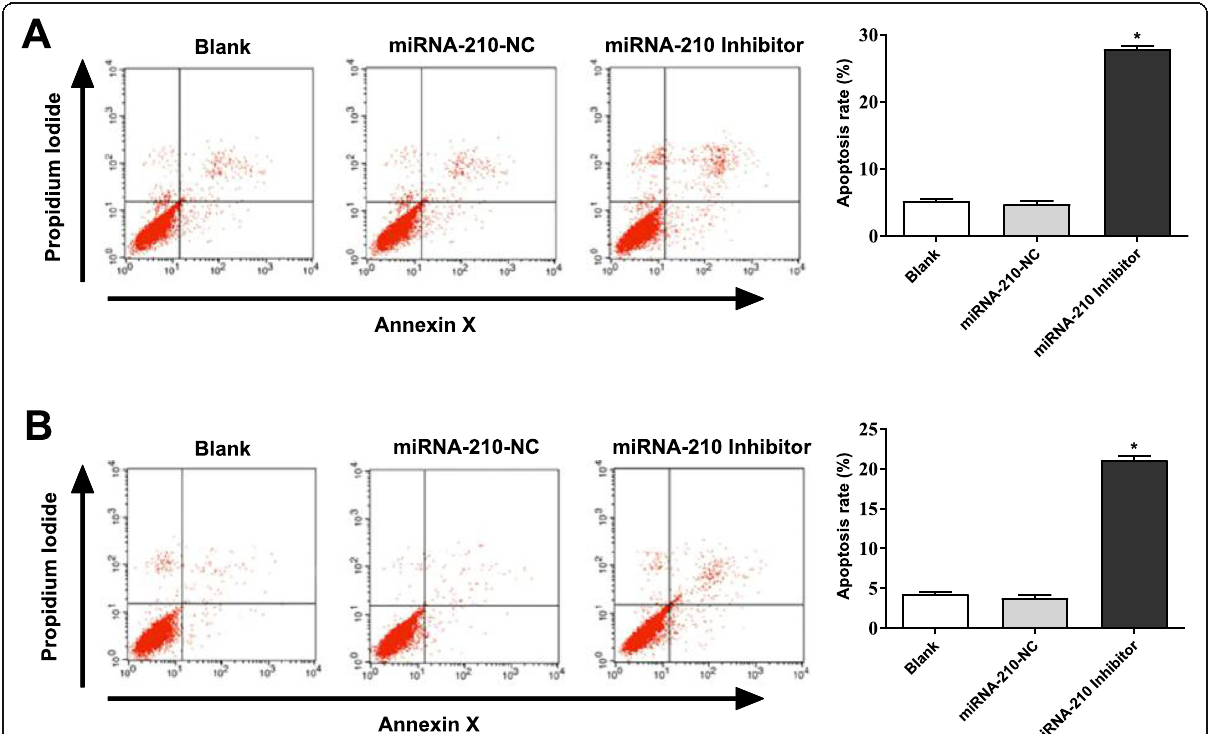
Fig. 4 Silencing of miRNA-210 promoted the apoptosis of HepG2 a and HepG2.2.15 b cells. * P < 0.05 compared with the Blank group. The experiment was performed in triplicate, and data were expressed as mean ± standard deviation